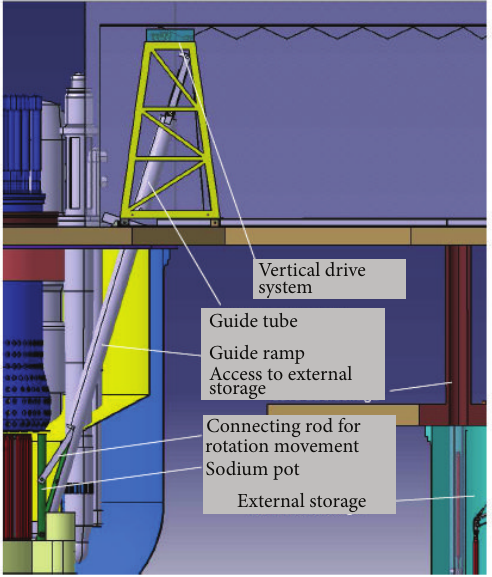
Figure 11: Horizontal transfer mechanism pot transfer